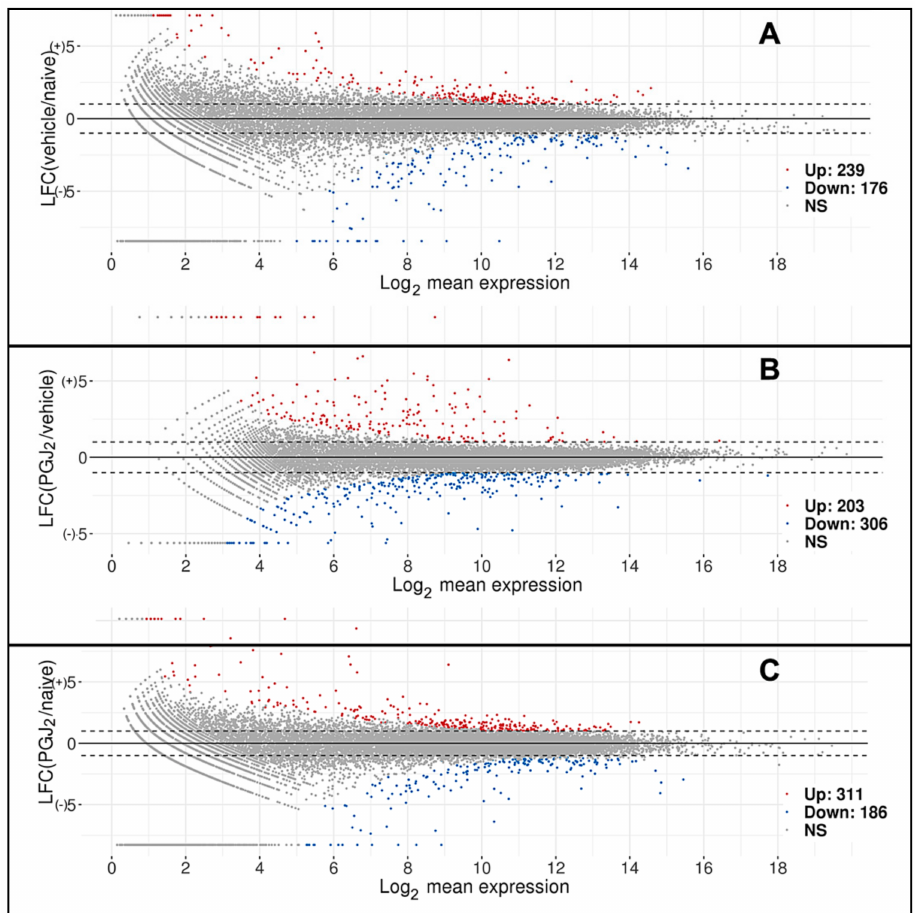
Figure 1. MA plots comparing differences between two samples and mean expression. Plots display the relationship between log-fold expression change (LFC: M) between the two samples and average expression. Log 2 mean expression: ( A ) Comparison between mean naïve and 3d post-rAION- induced, vehicle-treated ONH. ( B ) Comparison between rAION-induced animals treated with PGJ 2 and vehicle. ( C ) Comparison between naïve and PGJ 2 -rAION-induced animals. Individual genes are shown in Supplemental Table S1. False discovery rate (FDR) was set at ≤ 0.05 and log 2 -fold change (LFC; on ordinate scale) ≥ +/1). Log 2 mean expressions for the genes are shown on the abscissa. Dashed lines indicate the LFC cutoff values of +/1. Points in gray indicate those genes that are not significantly expressed. Points colored in red indicate the upregulated genes, while points in blue indicate the downregulated